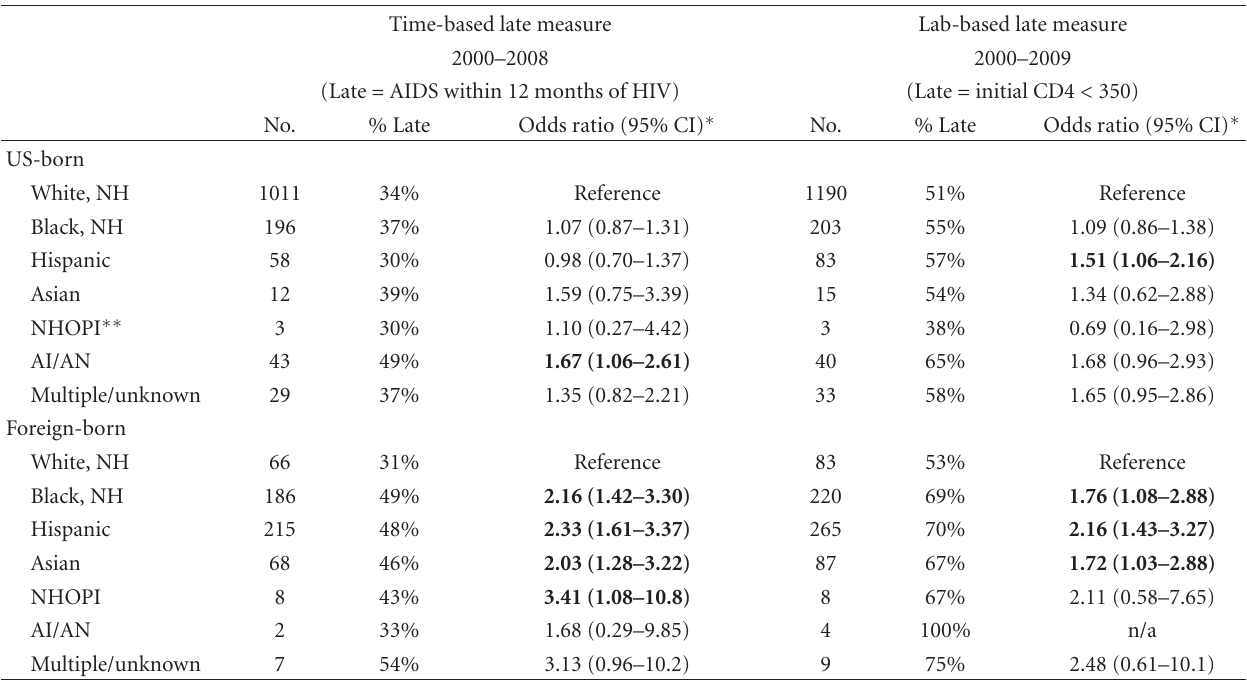
Table 3: Late HIV diagnoses by race/ethnicity and foreign-born status, Washington State,